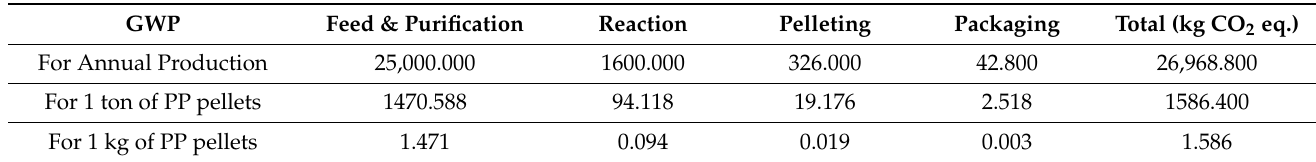
Figure 5. An overview of the impact categories results for each phase of the PP manufacturing process, where each category is represented separately based on the annual production of PP pellets. Table 3. An overview of the global warming potential impact category results, which were measured for each process of the PP manufacturing plant.